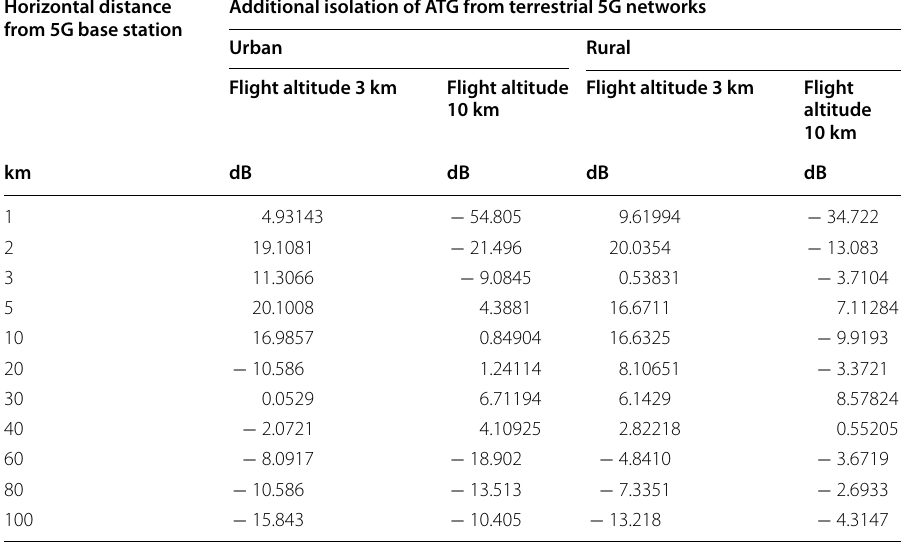
Table 5 Deterministic calculation conclusion Horizontal distance Additional isolation of ATG from terrestrial 5G from 5G base station